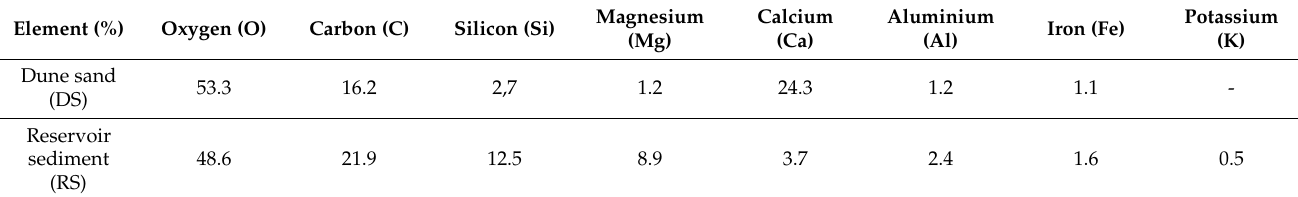
Table 1. Elemental analysis of the tested material obtained from field emission scanning electron microscope with energy dispersive spectroscopy